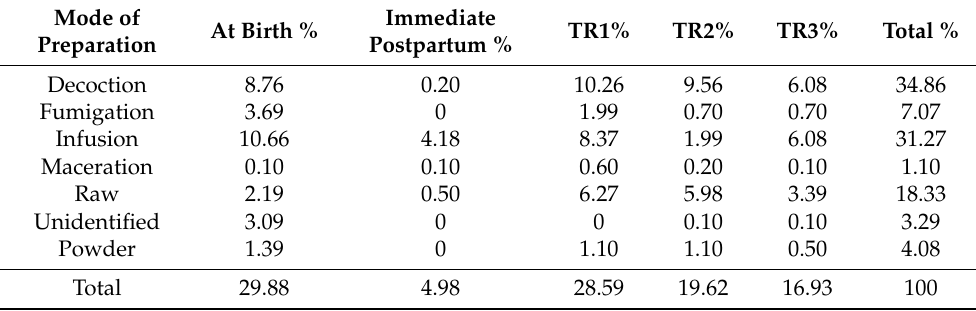
Table 5. Distribution of medicinal plants according to their mode of preparation.